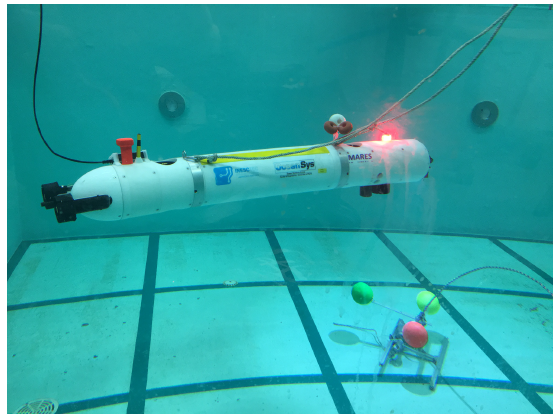
Figure 1. MARES tracking the visual